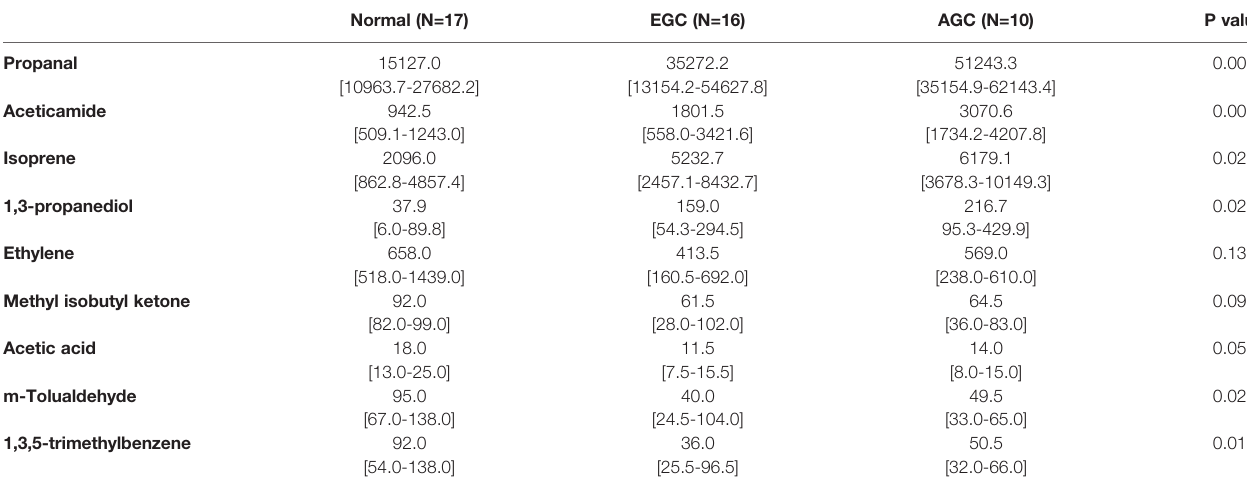
TABLE 1 | Counts per second of the VOCs according to the Cancer